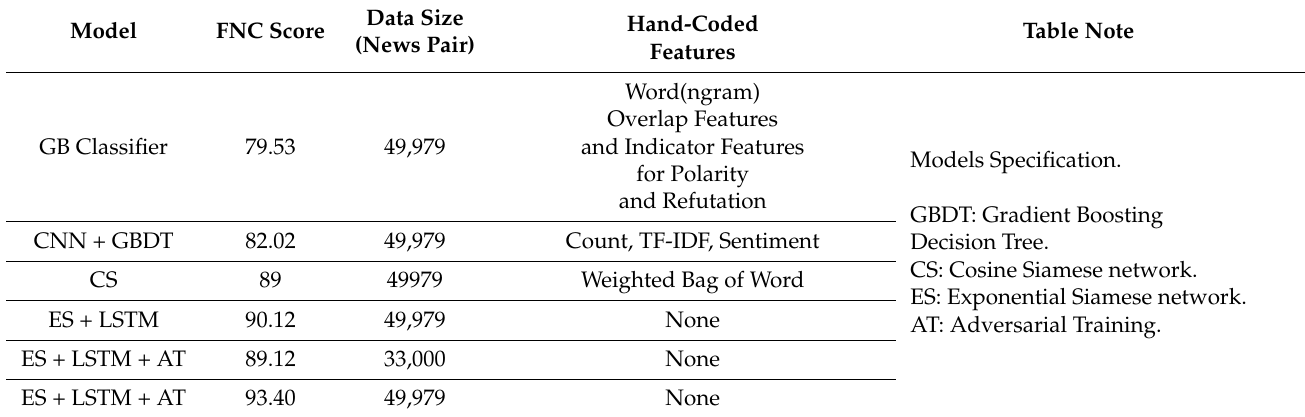
Table 4. Results of